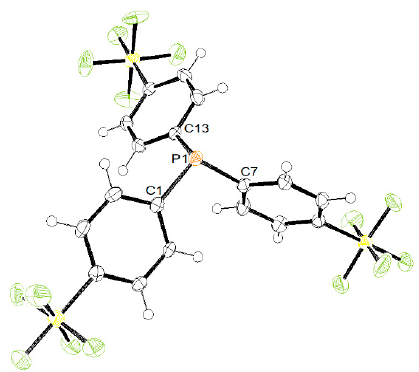
Figure 1. ORTEP representation of 1 with thermal ellipsoids drawn at 50% probability level. The C 6 H 6 molecule in the asymmetric unit has been omitted for clarity. Selected bond lengths [Å] and bond